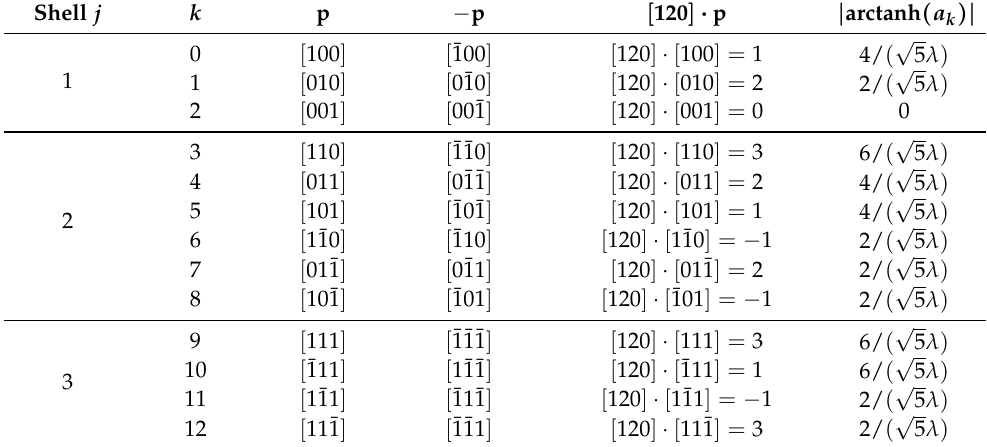
Table 1. The three different neighboring shells and all related grid directions within the simple cubic numerical grid. Exemplary determination of the grid coupling parameter set for the TI (cid:104) 120 (cid:105) − formulation, which restores translational invariance (TI) in the (cid:104) 120 (cid:105)− directions of the numerical